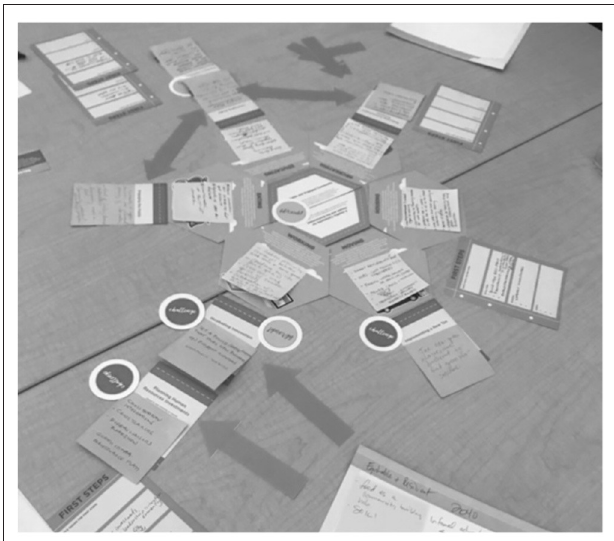
FIGURE 5 | Completed gameboard (taken during game play in the city of